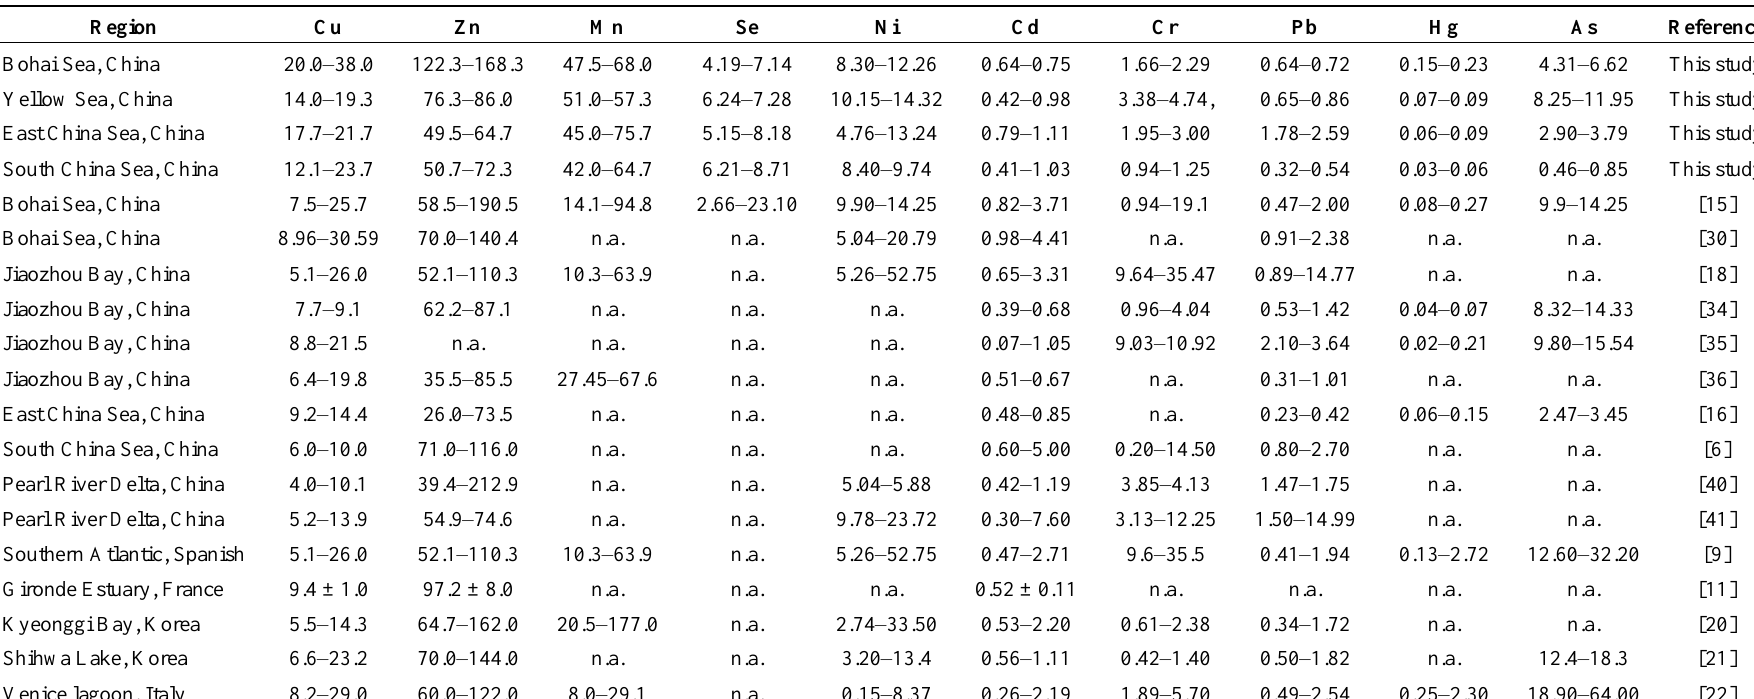
Table 2. Comparison trace element concentrations (mg·kg −1 dry weight) in Ruditapes philippinarum obtained in the present study with literature data from China and other regions all over the world. n.a.: no available